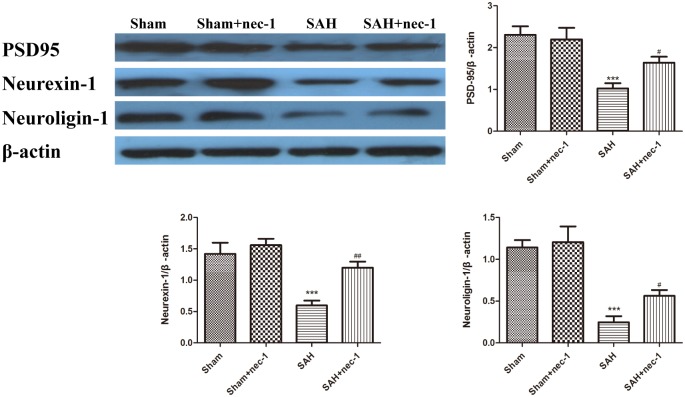
The effect of nec-1 on synaptic protein expression. The protective impact of Nec-1 on synapses was detected by western blotting. The results revealed a decrease of synaptic proteins after SAH occurred compared to the Sham group. Treatment with Nec-1 increased the expression of synaptic proteins. Bar graphs showing the quantification of the protein levels of PSD-95, neurexin, and neuroligin. The results are expressed as the PSD95, neurexin-1 and neuroligin-1/β-actin ratio (n = 3). The values represent the mean ± SD. ∗∗∗P < 0.001 SAH vs. Sham, #P < 0.05, ##P < 0.01, SAH+nec-1 vs. SAH.